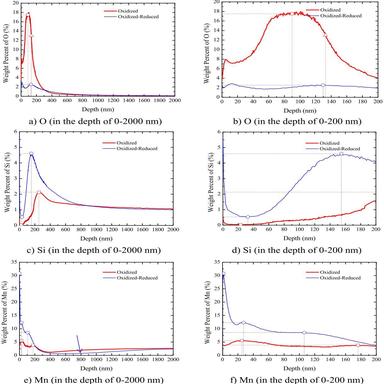
Comparison of the O, Si and Mn depth profiles between the oxidized and oxidized-reduced samples. a) O (in the depth of 0–2000 nm), b) O (in the depth of 0–200 nm), c) Si (in the depth of 0–2000 nm), d) Si (in the depth of 0–200 nm), e) Mn (in the depth of 0–2000 nm), f) Mn (in the depth of 0–200 nm).